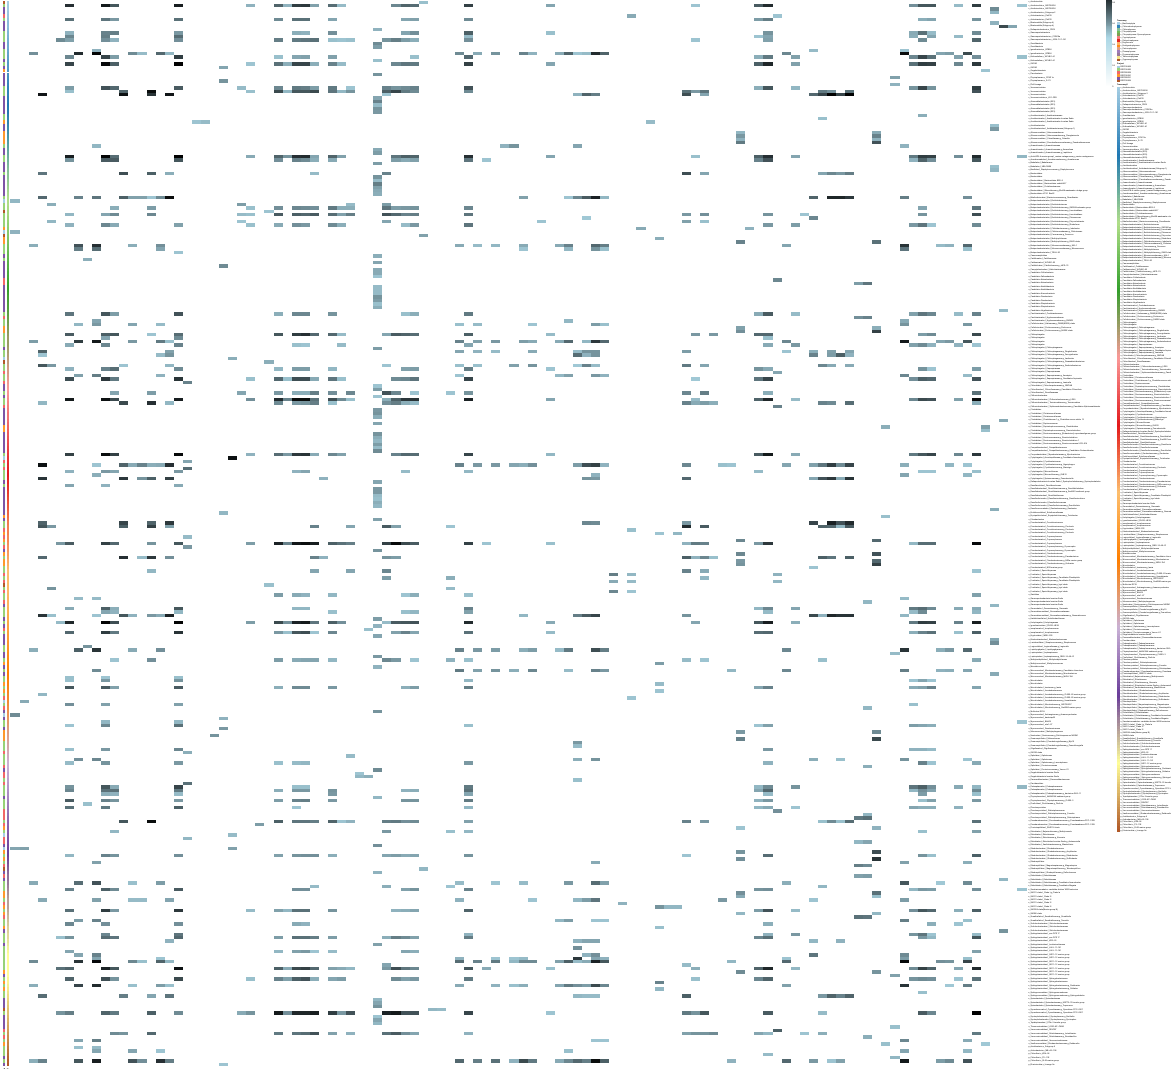
Figure 2. Summarised interactions in Freshwater environments. Correlation heatmap of co-occurring microalgae (columns) and bacteria (rows) in freshwater environments . “Taxonomy” represents the taxonomic affiliations of microalgal nodes at class level. “Taxonomy2” represents the taxonomic affiliations of bacteria (p_, c_, o_, f_ and g_ represent Phylum, Class, Order, Family and Genus, respectively). “Project” represents the accessions of EMP projects and indicate which project the microalgal and bacterial nodes were recovered from. “Sample_origin” indicates if each sample is planktonic or benthic. Heatmap colour gradient indicates correlation coefficients. Refer Table S3 for raw data used to generate the heatmap. Heatmap was generated using Pheatmap v1.0.12 (https:// rdrr. io/ cran/ pheat